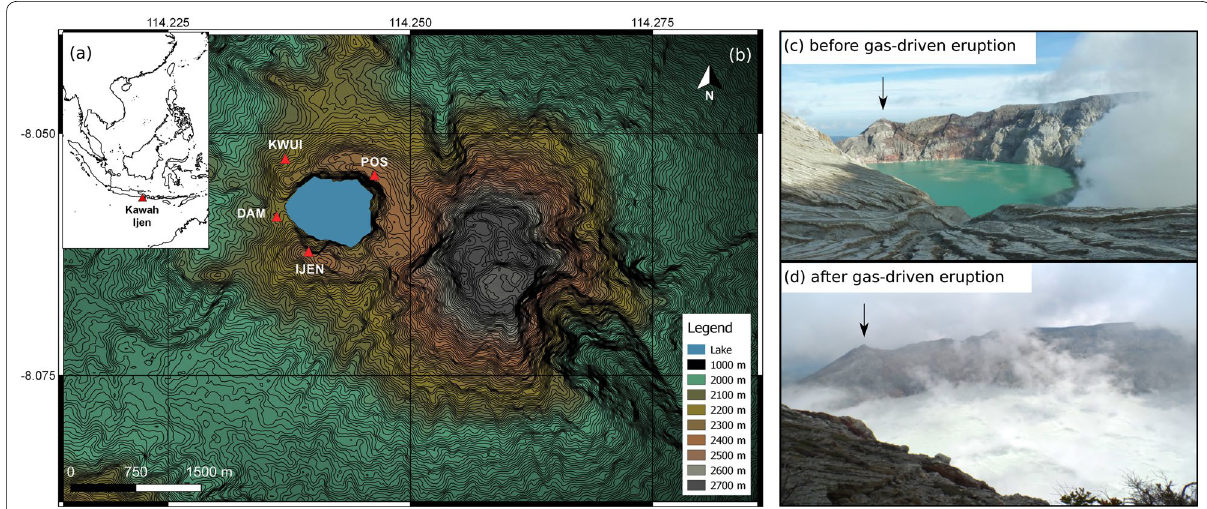
Fig. 1 Kawah Ijen phreatic eruption and seismic network. a Kawah Ijen location in South East Asia. b Seismic stations locations in the crater (POS and DAM are broadband seismic stations, whereas KWUI and TRWI are short-period seismic stations). c Photograph taken on 11 March, 9 days before the phreatic eruption on 20 March 2013 (the persistent degassing is emitted by the fumarole). d Photograph taken on 27 March 2013, 7 days after the eruption. The arrow indicates a common feature on the